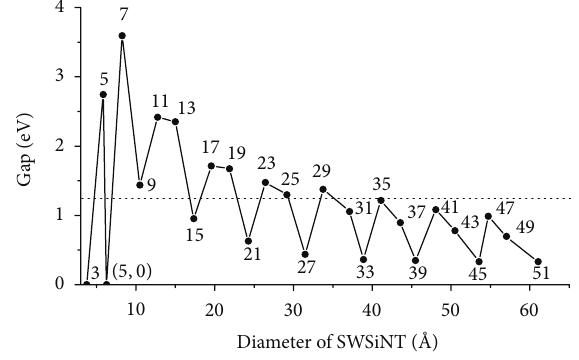
Figure 10: Calculated gap of SWSiNTs as a function of nanotube diameter. The numbers at the peaks are 𝑚 𝑎 -values of particular helical group which determine directly also the fold-number of particular tubular rotational axis symmetry. Horizontal dotted line indicates calculated gap (1.24eV) of bulk silicon with cF8 diamond- like structure.